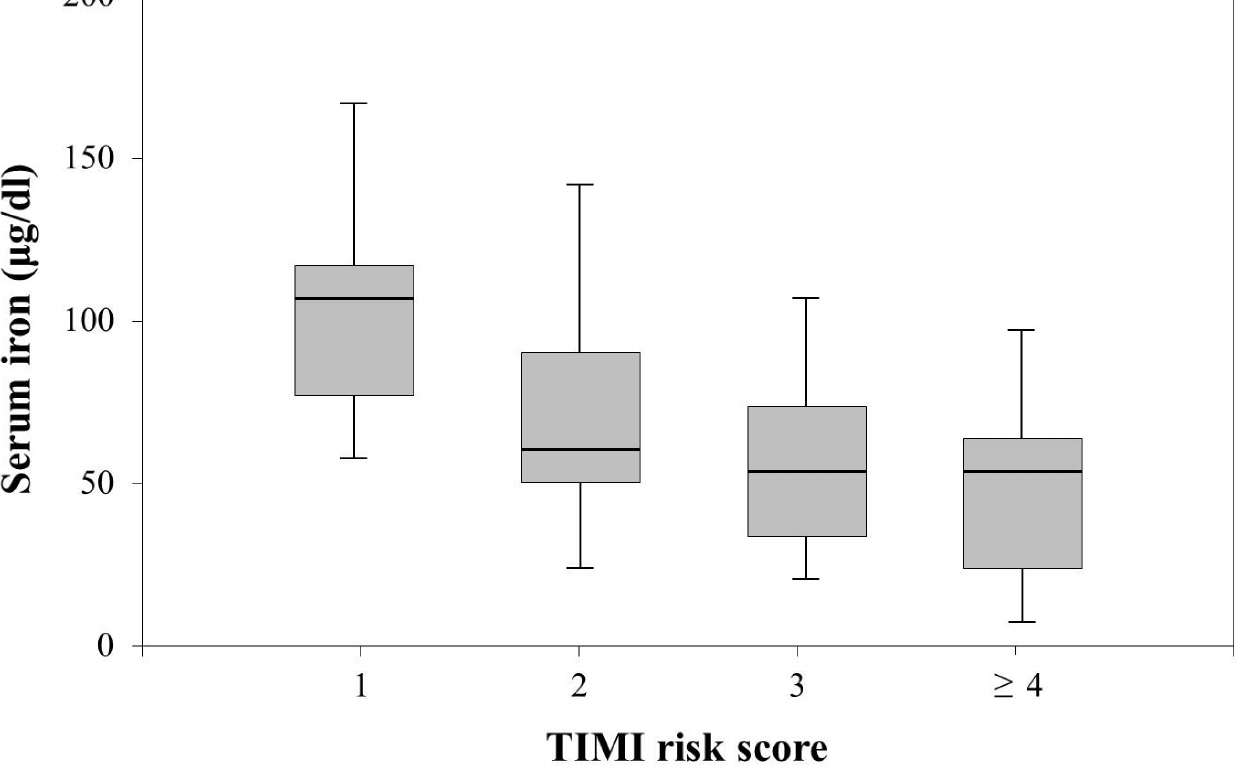
Figure 1. The relationships between serum iron concentration and TIMI risk scores after primary angioplasty for AMI. The AMI patients were divided into four subgroups according to TIMI risk score for STEMI: Group 1 (TIMI risk score 1, n=8); Group 2 (TIMI risk score 2, n=15); Group 3 (TIMI risk score 3, n=19); and Group 4 (TIMI risk score $ 4, n=13). Trend analysis with Jonckheere-Terpstra test found that serum iron concentration significantly decreased as TIMI risk score rose ( P